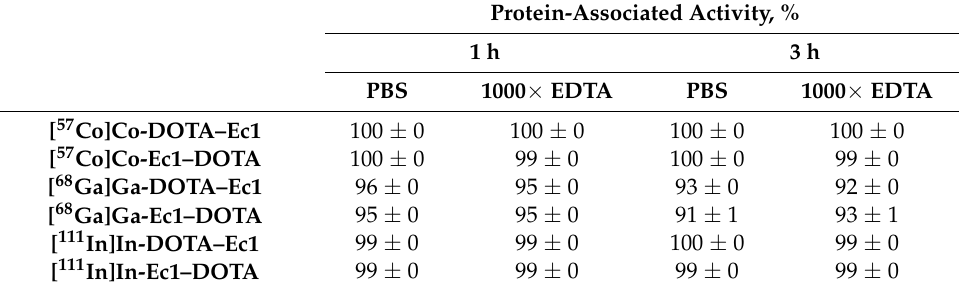
Table 2. In vitro stability of Ec1 conjugates labeled with radiometals. The conjugates were incubated for 1 and 3 h with a 1000-fold molar excess of EDTA and compared to PBS control. Analysis was performed in duplicates. The values for each conjugate were normalized to its starting radiochemical purity, taken as 100%.